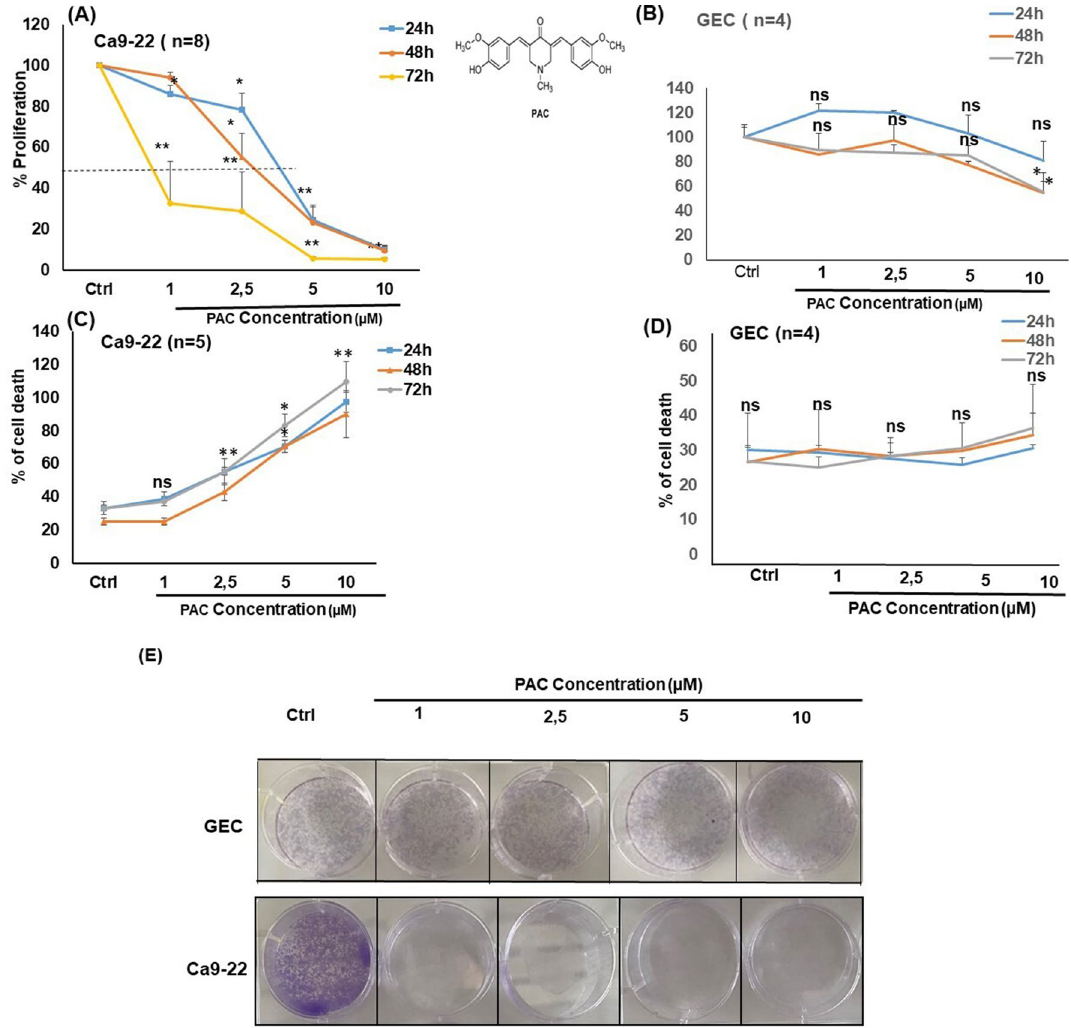
Figure 1. PAC have preferentially ant proliferative activity and cytotoxicity against Ca9-22 cells, but not on normal human gingival epithelial cells. ( A ) PAC at various concentrations decrease the growth of oral cancer cells. This decrease was more important with higher concentration of PAC (n = 7). ( B ) The normal human gingival epithelial cells (GEC) cells, a slight decrease was observed only at the highest concentration of PAC (10 μM) after 48 h ( p = 0.02) and 72 h ( p = 0.03) (n = 4). ( C ) A treatment with PAC was inducing dose- and time-dependent cell death in Ca9-22. ( D ) Lactate dehydrogenase (LDH) assay: PAC don’t induce cell death in GEC cells (n = 4). ( E ) PAC inhibits ca9-22 colony formation but not in GEC. The cells were treated with various concentrations of PAC. The culture medium was changed every 2 or 3 days. After 2 weeks, the cell clones that survived were fixed by 100% ethanol for 10 min. After washing twice by PBS, cells were then stained with 0.5% crystal violet for 30 min and they were photographed with a digital camera (n = PAC. In contrary, the S population increases from 6.85% ± 3.74% in controls to 38.95% ± 17.18%, p < 0.005 using the same concentration it. The G2/M population is also doing it as the previous one, from 5.05% ± 1.34% to 48.7% ± 13.85% p < 0.005 with the same treatment (Fig. 3A,B). PAC induces apoptosis in oral cancer cells by targeting the intrinsic mitochondrial path‑ way. In determining the type of death induced by various concentrations of PAC on oral cancer cells, the fluorochrome-labeled annexin V with PI was used. Our results show the presence of 4 different sub-populations referring to live cells (annexin V-/PI-), early apoptotic cells (annexin V + /PI−), late apoptotic cells (annexin V + / PI +) and necrotic cells (annexin V−/PI +). After 24 h of exposure to PAC, the percentage for the first popula- tion decreases from 96.48% for untreated to 71.29% with 5 µM, and 18.32% with 10 µM. Conversely, the early apoptotic cells were increasing from 2.56% with the control to 18.62 with 5 µM. In late apoptotic population was much higher with PAC exposure ranging from, 1.09% with the controls to 55.46% with 10 µM of PAC. The necrotic population was also increasing from 0.87% with the untreated cells to 24.48% with 10 µM PAC treated oral cancer cells (Fig. 4A). To confirm apoptosis—inducing ability of PAC concentration on oral cancer cells, we